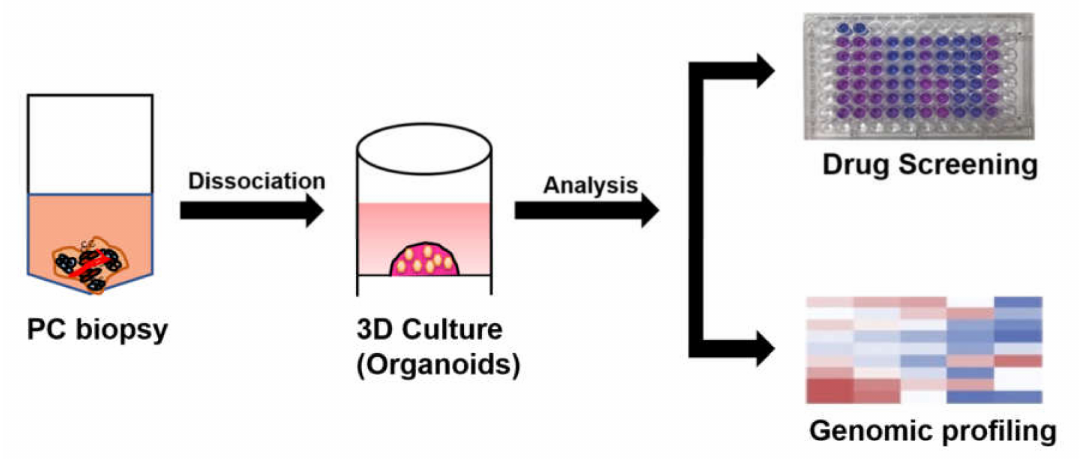
Figure 4. PC organoids for drug screening. After the biopsy samples are mechanically minced and enzymatically digested, the cell suspension is strained, washed and embedded within Matrigel to form organoids. After serial passaging, the 3D organoids can be used for drug screening as well as genomic